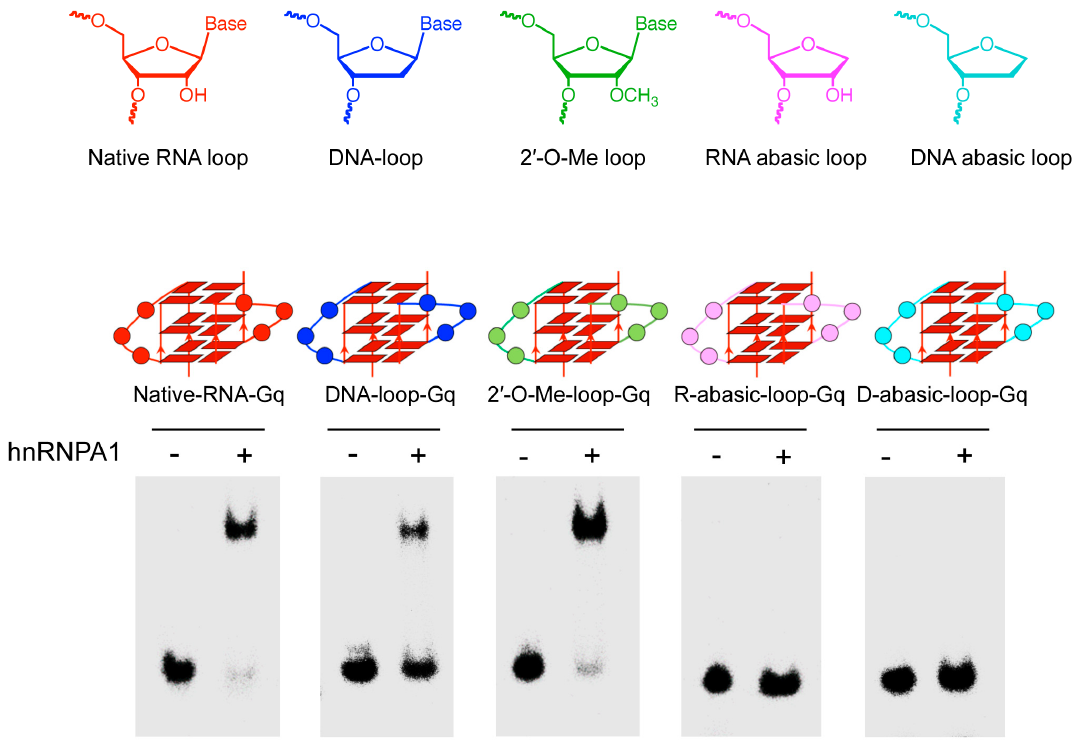
Figure 1. Effect of base of nucleotide at the loop of G-quadruplex RNA on the binding of heterogeneous nuclear ribonucleoprotein A1 (hnRNPA1). Electrophoretic mobility shift assay (EMSA) was performed with hnRNPA1 and 32 P-labeled RNAs using 8% PAGE in 1 × TBE buffer with 20 mM NaCl in 4 ◦ C for 2 h (80 V). The structures of DNA loop (DNA-loop-Gq), abasic RNA loop (D-abasic-loop-Gq), abasic DNA loop (R-abasic-loop-Gq) and 2’-O-methylribonucleotide loop (2 (cid:48) -O-Me-loop-Gq) are indicated at